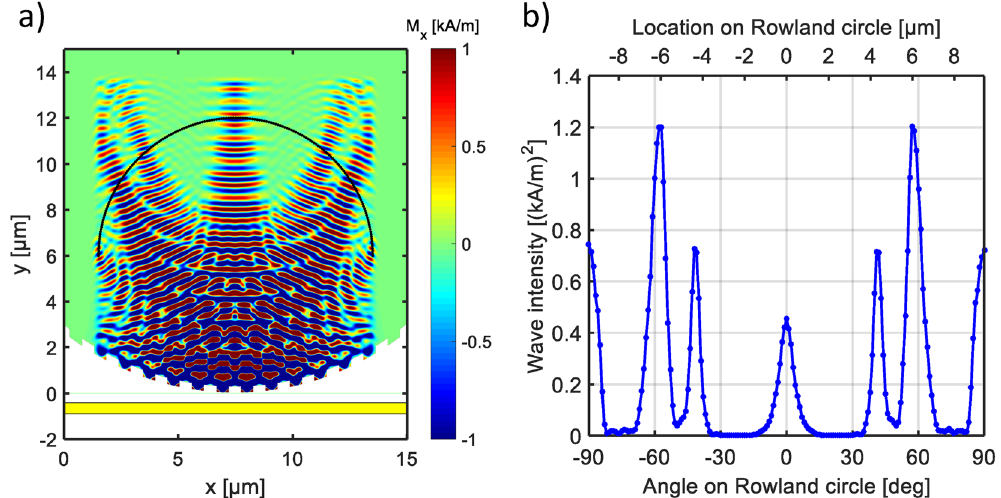
Figure 6. Micromagnetic simulation of the spin-wave-based Rowland circle spectrometer. ( a ) The colormap shows a magnetization snapshot of a YIG film, the peaks on the Rowland circle correspond to frequencies f 1 = 10 GHz and f 2 = 10.25 GHz. The yellow stripe at the bottom is a sketch of the microstrip that is used as a source. ( b ) Spin-wave amplitude along the Rowland circle indicated by black arc in ( a